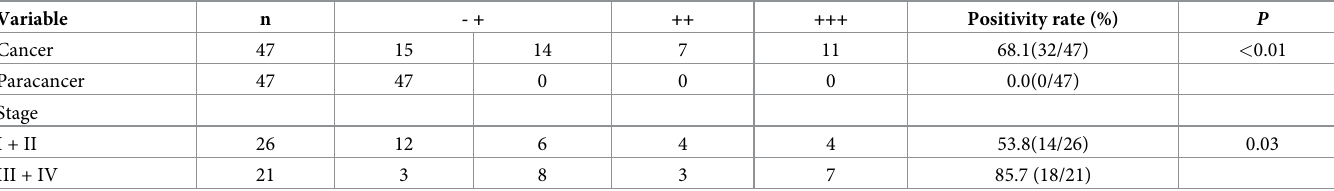
Table 1. Positive expression rate of CST1 in cancerous and paired paracancerous tissues of ESCC patients. Variable